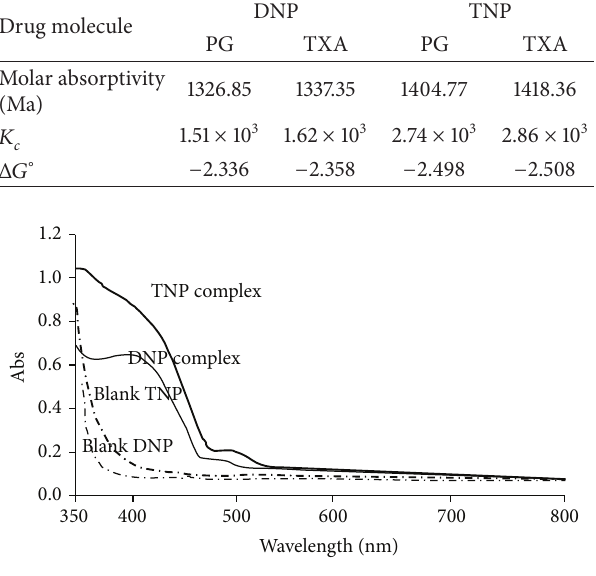
Figure 3: Spectrum of complexes and